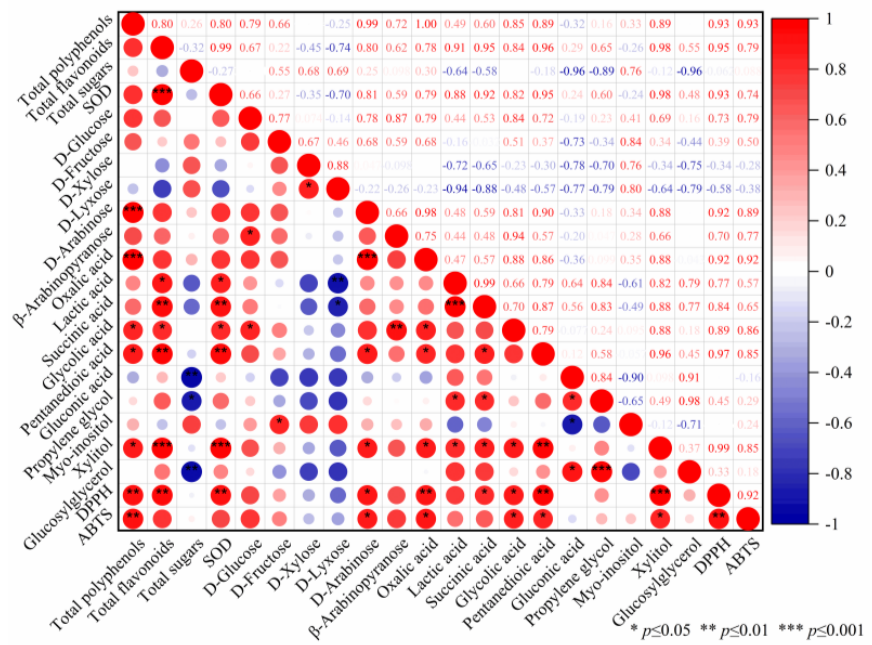
Figure 4. Pearson correlation coefficients between biochemical compositions and antioxidant activities.